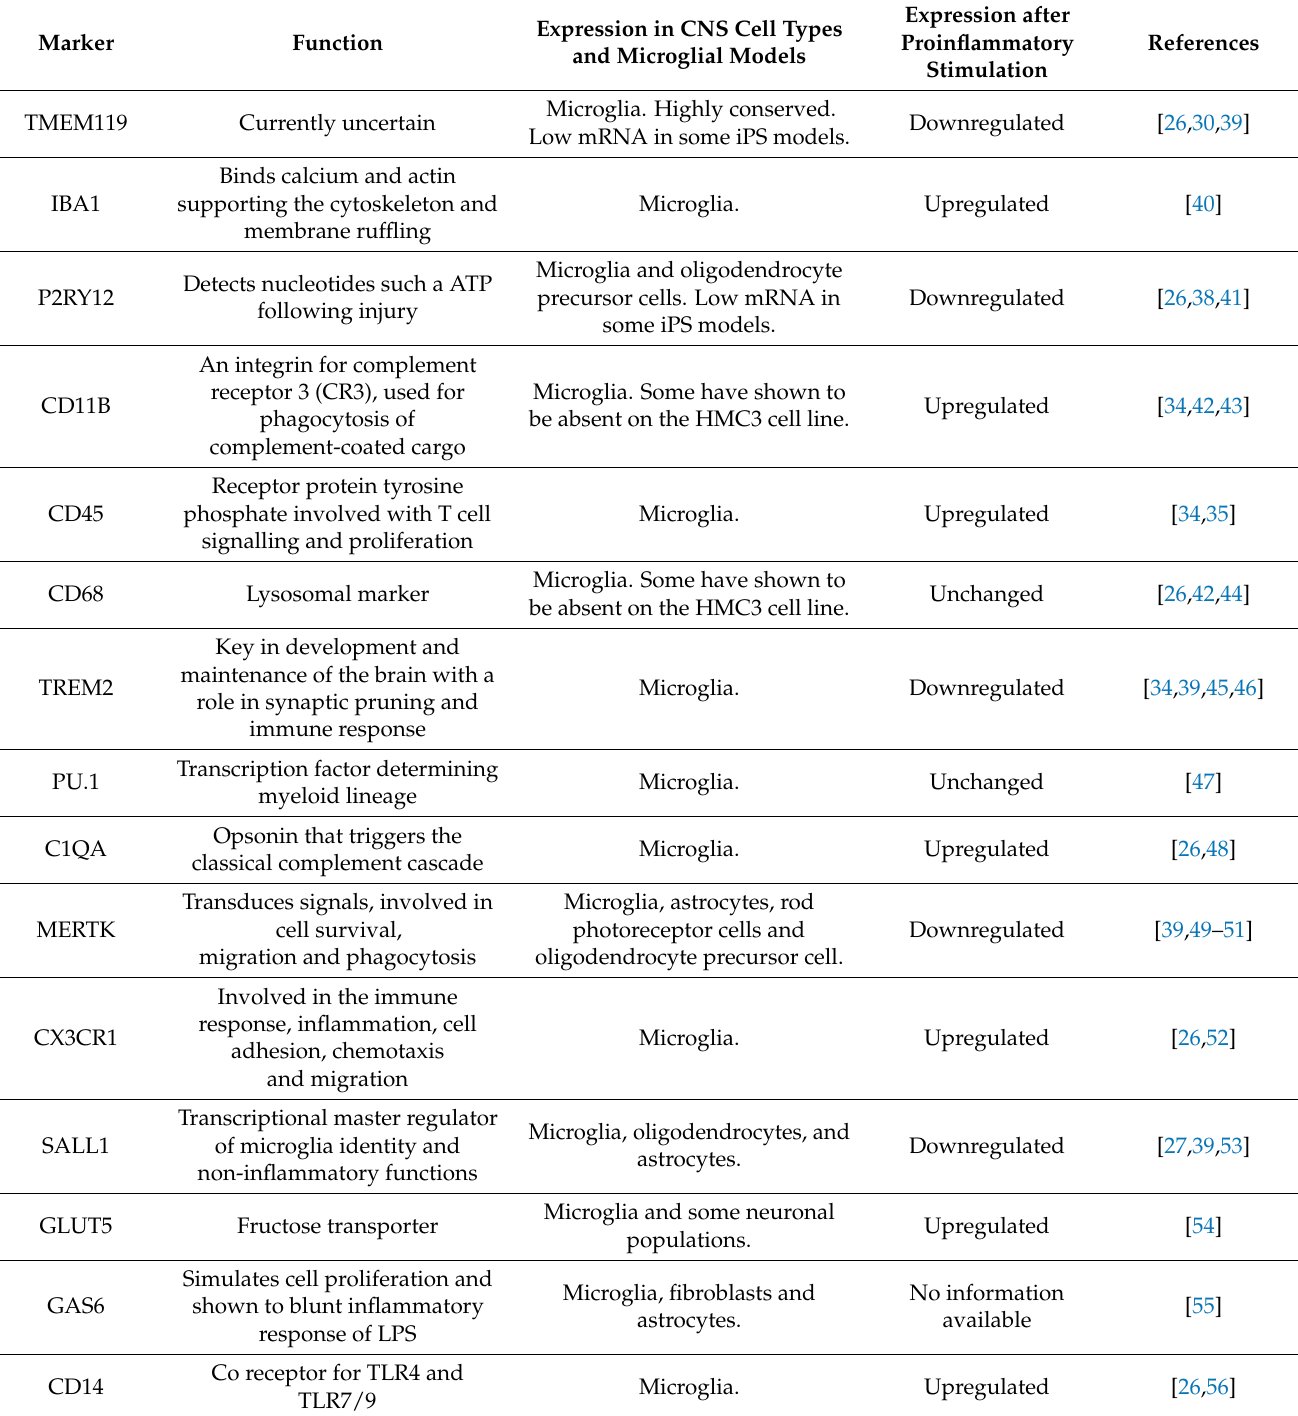
Common microglia identity markers. TMEM119—Transmembrane protein